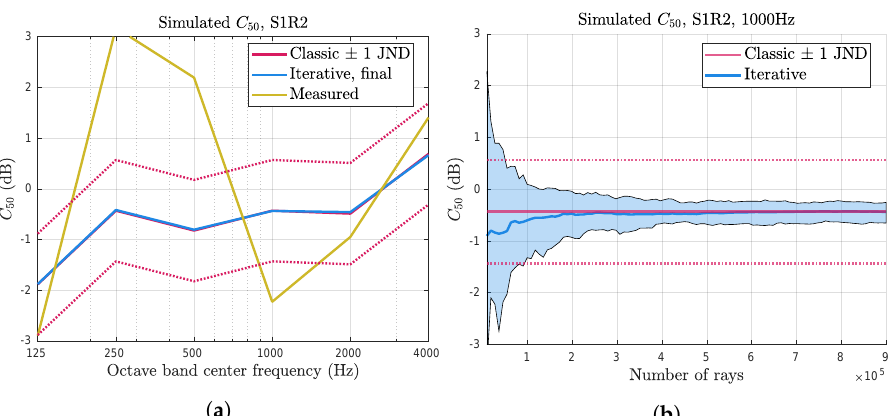
Figure 11. Speech clarity C 50 for one position, measured and estimated from classic and iterative simulation data sets. In ( a ), the results for the maximum number of rays are shown. ( b ) shows the estimate for 1000 Hz increasing number of rays in the iterative algorithm and shows the results for the full classic simulation. The shaded area illustrates the spread of estimates in the iterative